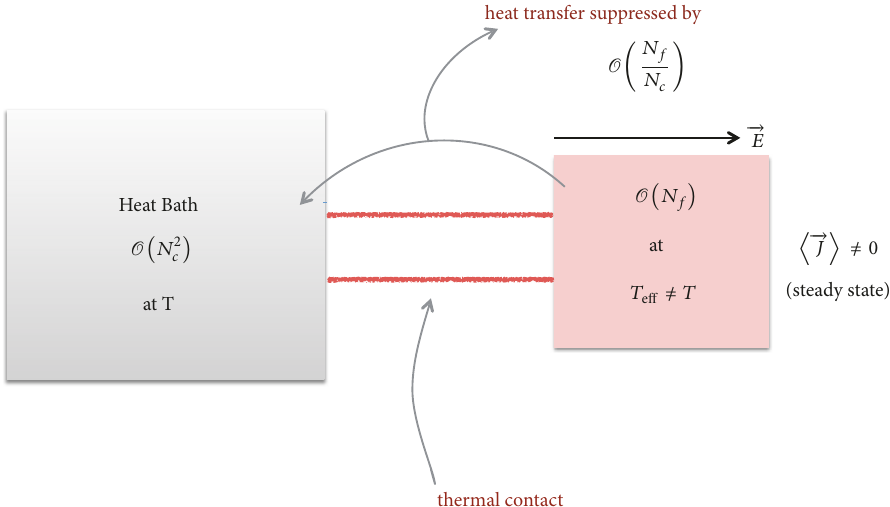
Figure 2: A schematic arrangement of the steady state. The O (𝑁 푓 ) fundamental degrees of freedom are in a steady-state, situated in a heat bath of O (𝑁 2 푐 ) degrees of